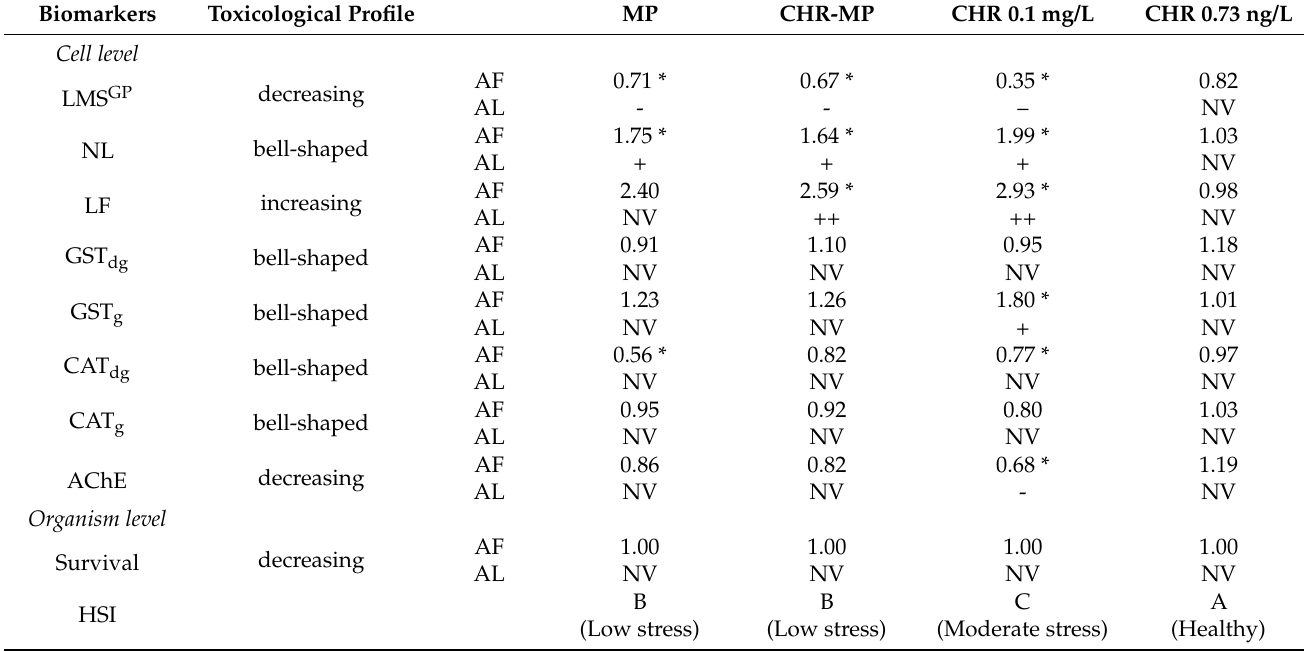
Table 2. Output of the Mussel Expert System (MES) integrating biomarker responses of adult mussels exposed to MP, CHR-MP and CHR treatments in a unique health status index